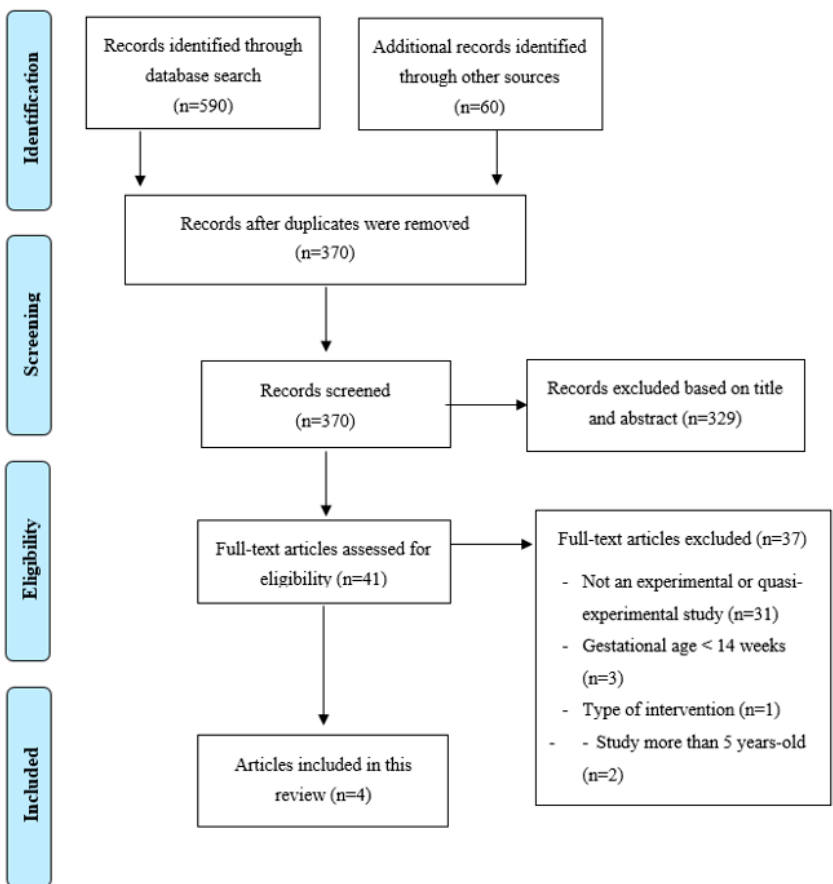
Figure 1. PRISMA study flowchart.